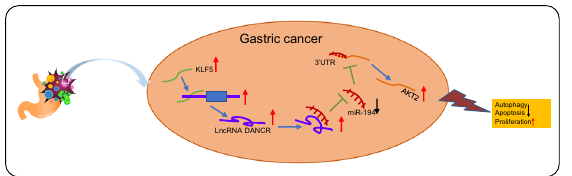
Fig. 8 Mechanism graph of the regulatory network and onco- genic function of KLF5 in gastric cancer. KLF5 activates the transcription of DANCR in the promoter region and elevates DANCR expression. DANCR acts as a miR-194 sponge to repress its expression. MiR-194 targets and inhibits AKT2 expression. Therefore, KLF5 promotes the malignant phenotypes of gastric cancer through activation of lncRNA DANCR and impairs miR-194-dependent AKT2